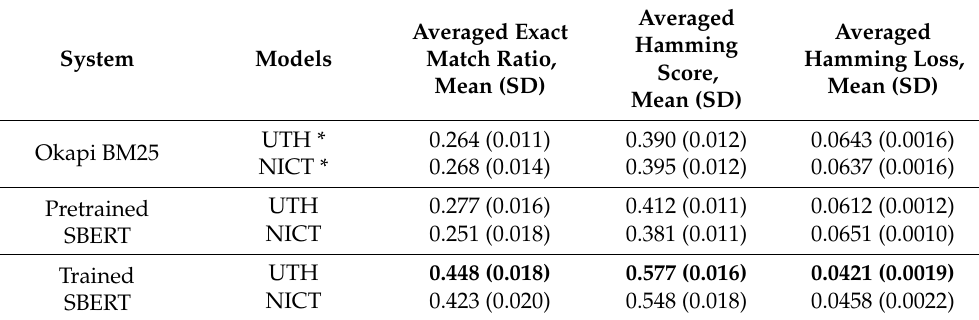
Table 3. Comparison between search engines; bold type indicates the best results. The value of each evaluation metric is the mean and the standard deviation (SD) of the results from 10 different random seeds. The UTH-BERT and NICT-BERT results are derived from the fifth and sixth iterations in the iterative optimization,